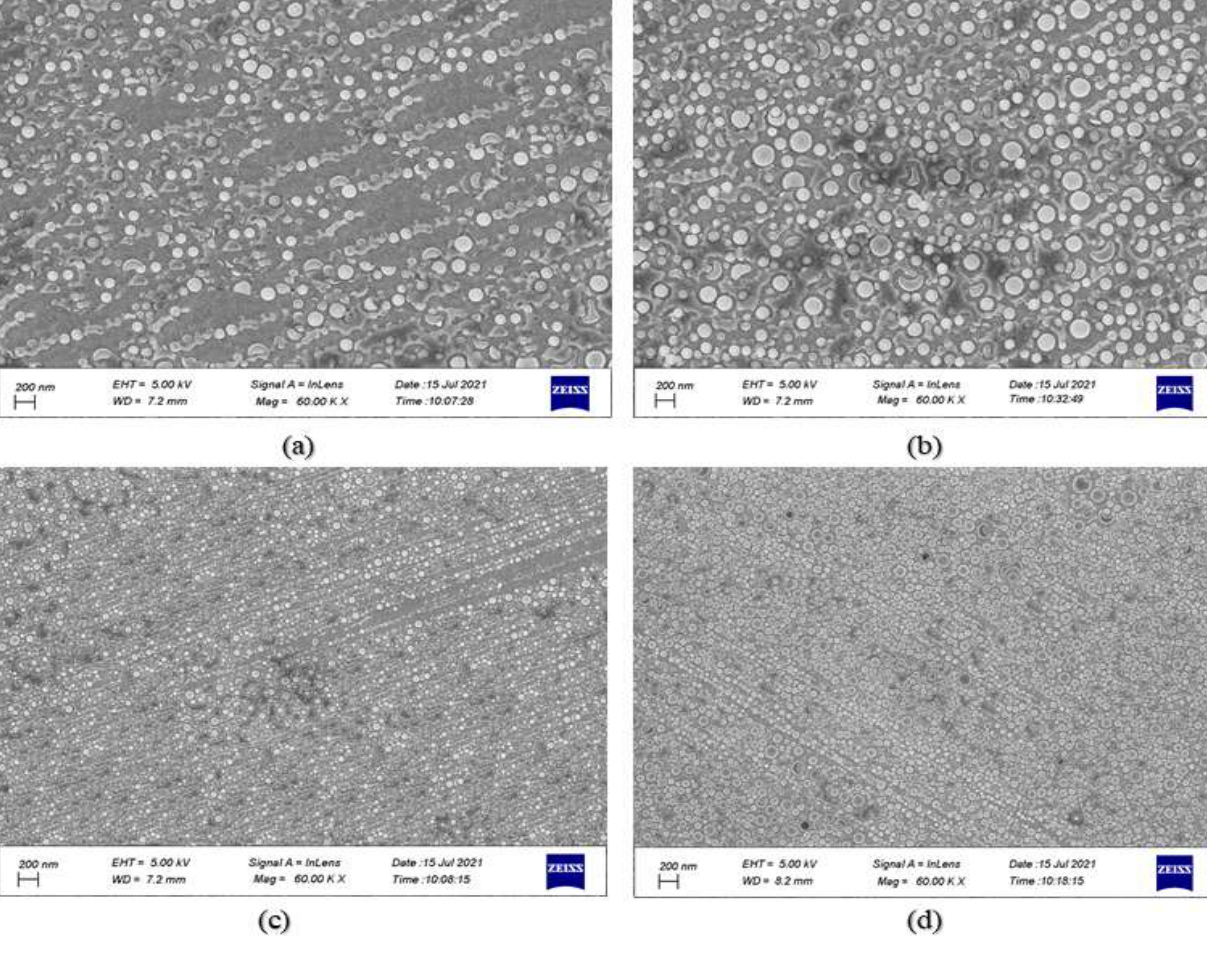
Figure 3. FE-SEM of Ti nanoparticles at 5and 10 min (a,b) on glass substrate and (c,d) on Si